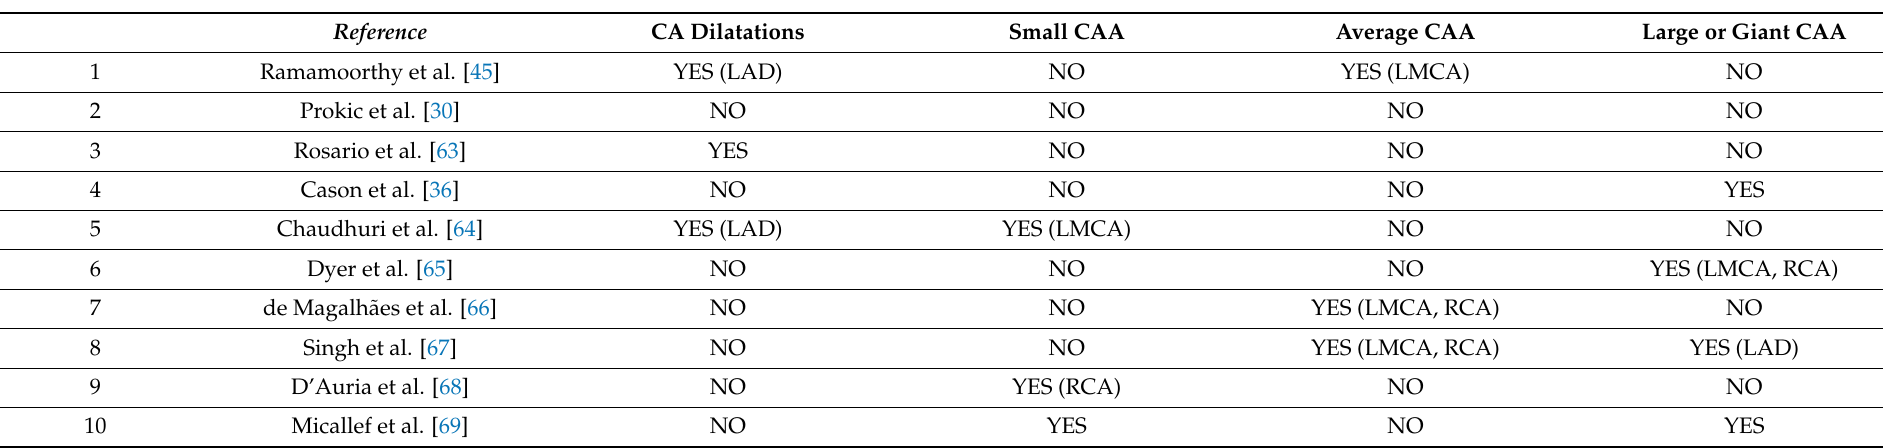
Table 3. Specific types of coronary artery involvement in case reports presenting ‘atypical’ pictures of Kawasaki